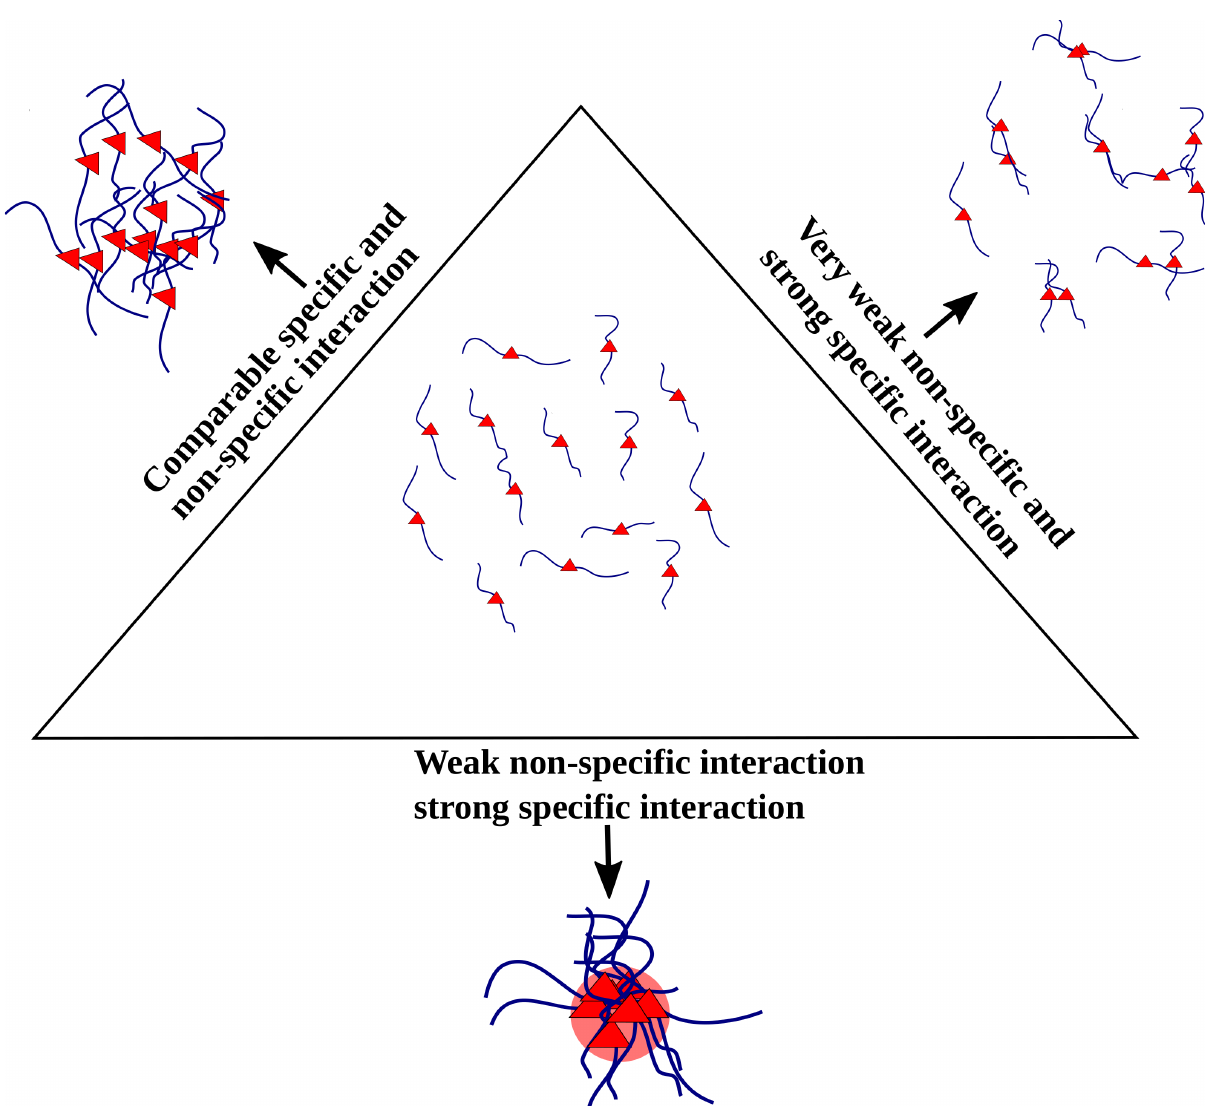
Fig 9. Schematic representation of the overall summary of the